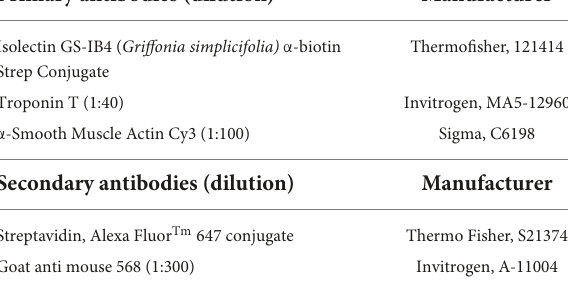
TABLE 1 Immunofluorescence antibodies and